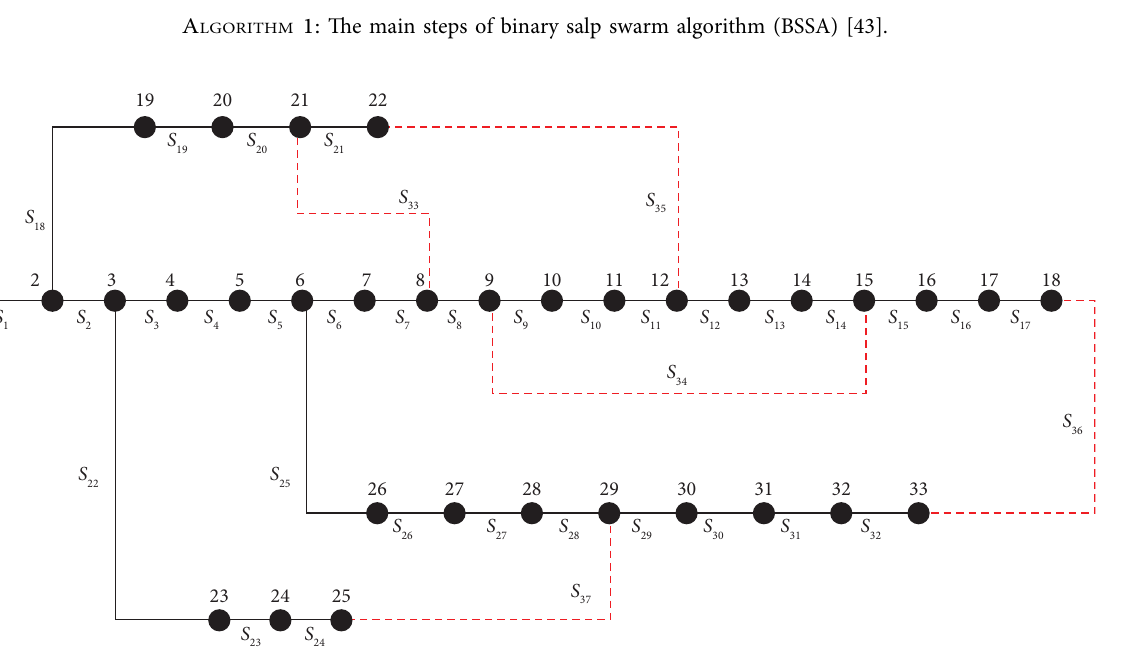
Figure 4: 33-bus IEEE system used in this